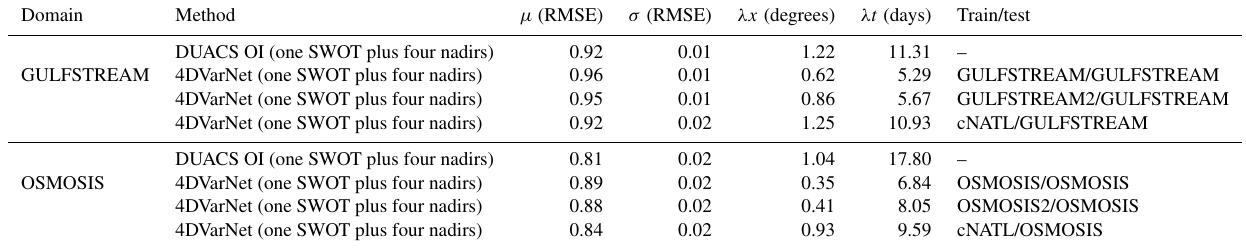
Table 4. 4DVarNet performance on the GULFSTREAM and OSMOSIS domain compared to DUACS OI over the period from 22 October to 2 December 2012 (42d).